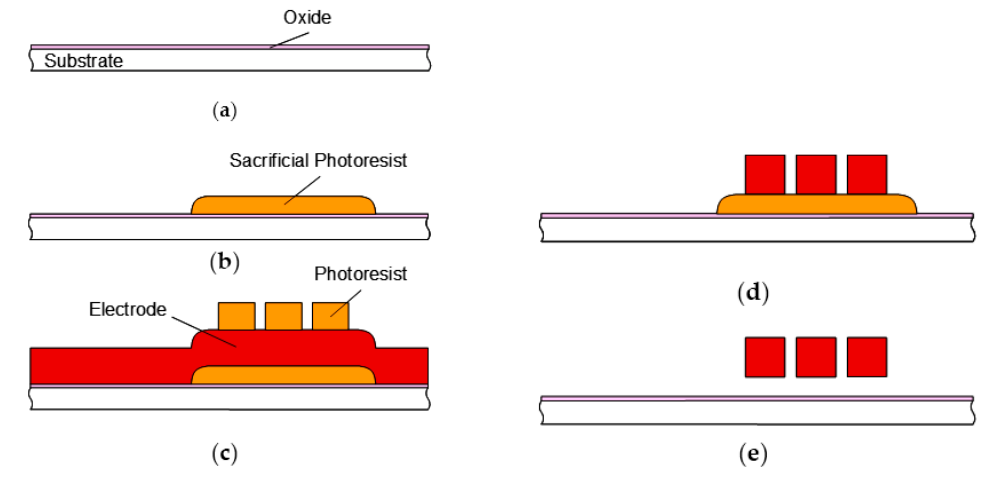
Figure 4. Fabrication process flow for sputtered-Al switch, ( a ) formation of isolation oxide on substrate; ( b ) formation of sacrificial photoresist; ( c ) Al deposition for electrodes, and photoresist formation; ( d ) Al etching; ( e ) release of electrodes as